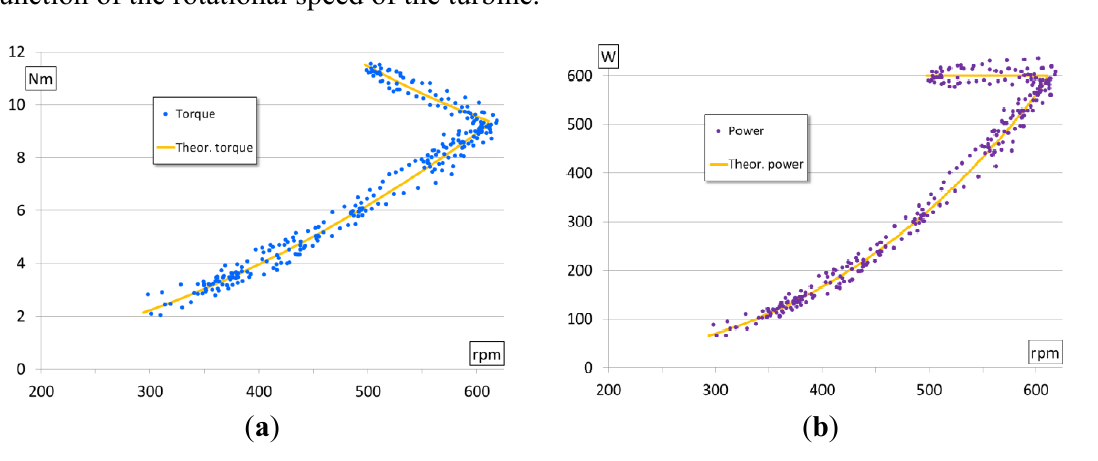
Figure 8. Relative performance of the turbine as a function of generated power and its linear regression.